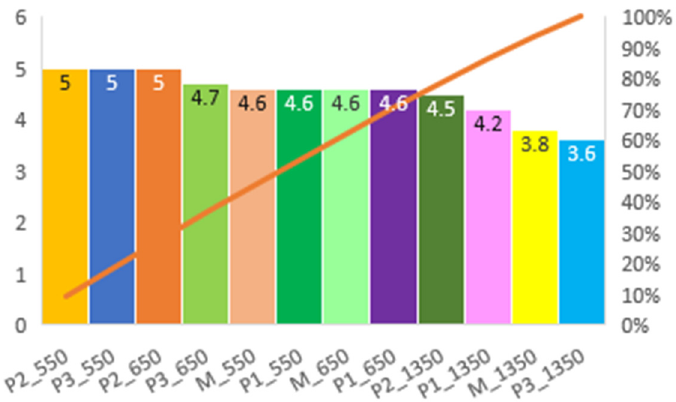
Figure 8. Sensory properties of bread samples.